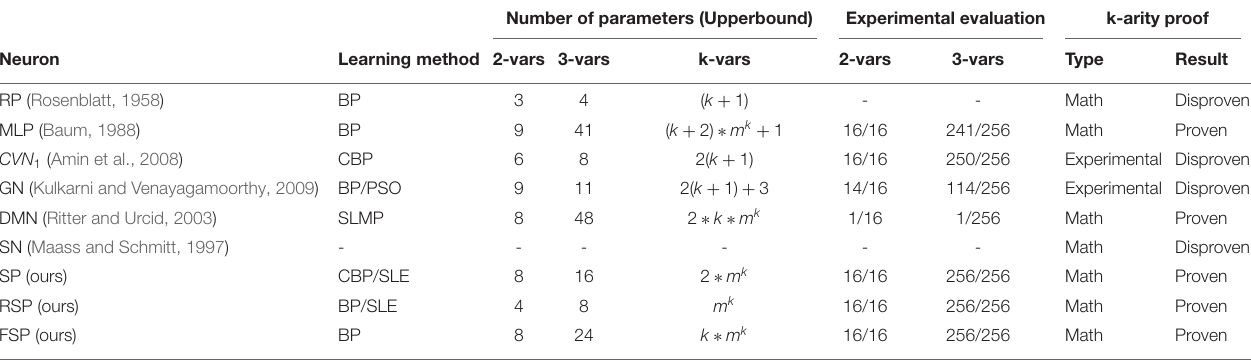
The table is divided into learning method, spatial complexity of each unit, experimental evaluation, and k-arity proof. Regarding the notation for the upper-bounds used to calculate the spatial complexity, the m term represents the domain size which for Boolean functions is m = 2 , k is the arity of the input size of each of the neurons. The symbol − means that the information was missing, not discussed, or not proven by the